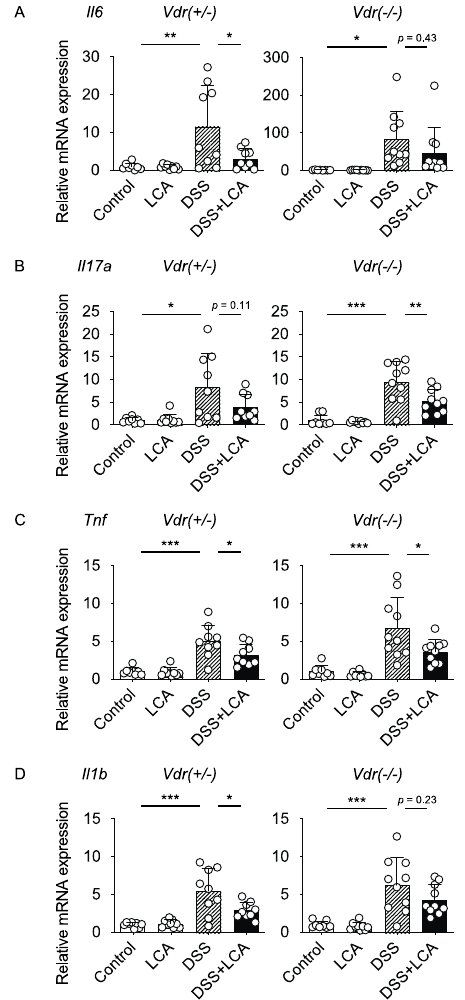
Figure 4. Effect of oral administration of LCA on inflammatory cytokine expression in the colon of Vdr(+/ − ) and Vdr( − / − ) mice. Colon samples were subjected to analysis at day 6, as shown in Figure 3A, and mRNA expressions of ( A ) Il6 , ( B ) Il17a , ( C ) Tnf , and ( D ) Il1b were determined with reverse-transcription and quantitative real-time polymerase chain reaction. Values for normalized mRNA expression are relative to those of control Vdr(+/ − ) mice. Data are presented as means ± S.D. * p < 0.05; ** p < 0.01; *** p < 0.001 (one-way ANOVA followed by Tukey’s multiple